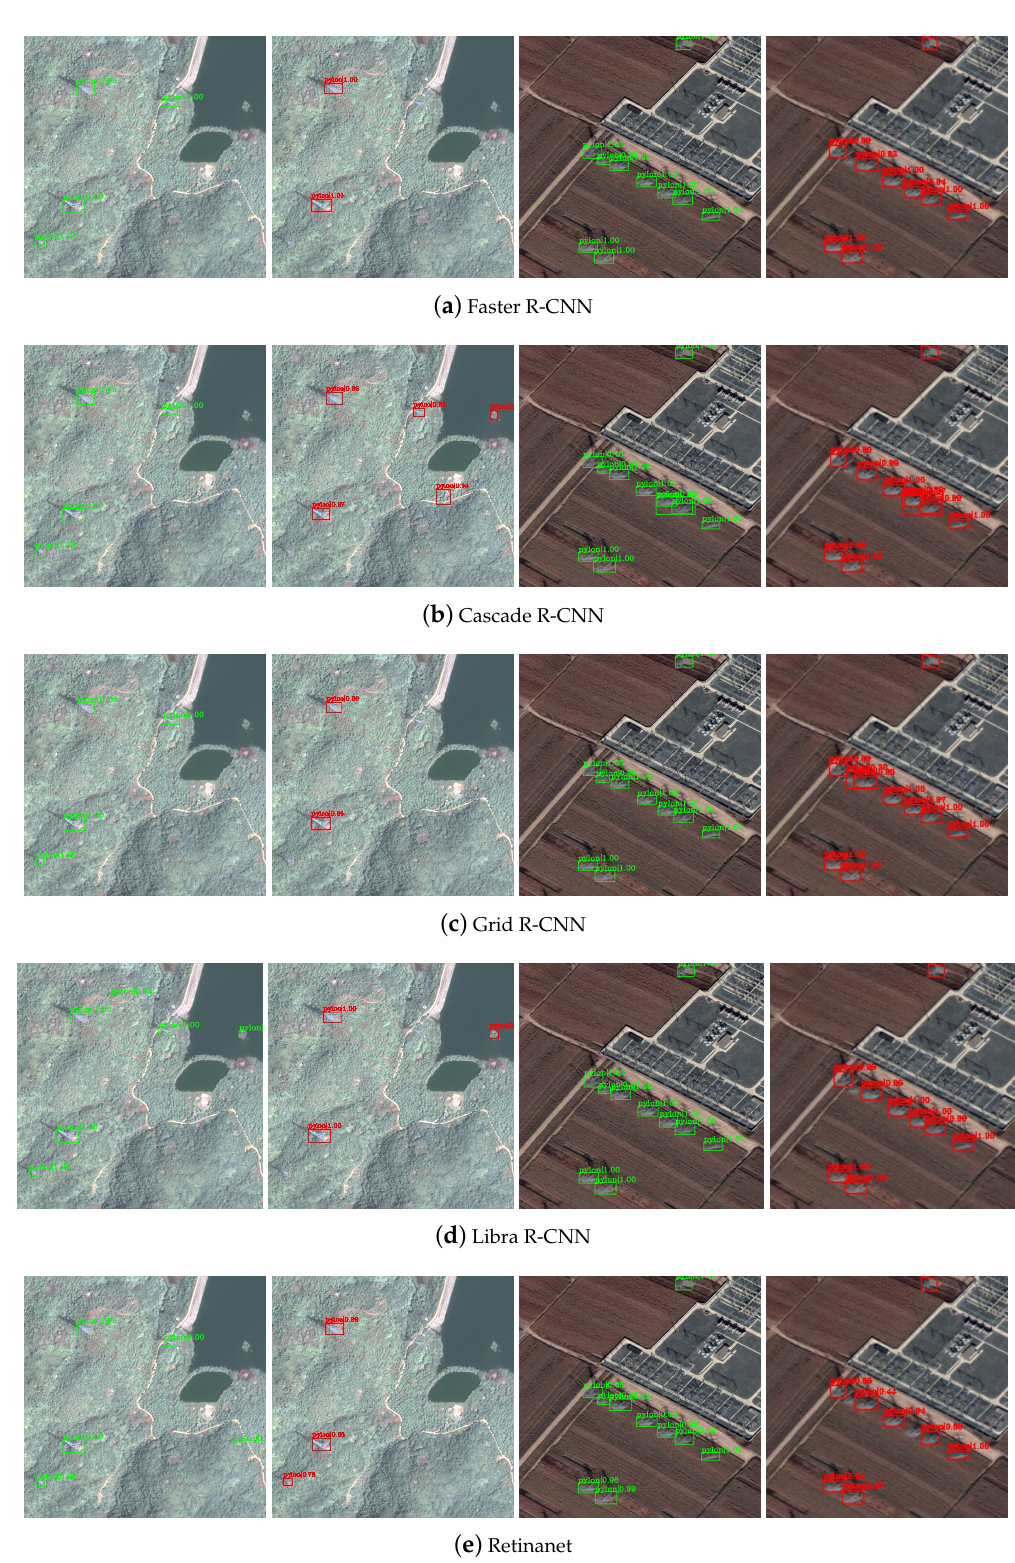
Figure 15. Visualization of experimental results on the EPD-C subset. We utilized detectors obtained from Section 4.3 to test two scenes in the EPD-C subset. For each scene, the left image is in 1-m resolution, while the right one is in 4-m resolution. Rows ( a – e ) show detection results of Faster R-CNN, Cascade R-CNN, Grid R-CNN, Libra R-CNN, and Retinanet, respectively. We use the green detection boxes in the 1-m images and the red detection boxes in the 4-m